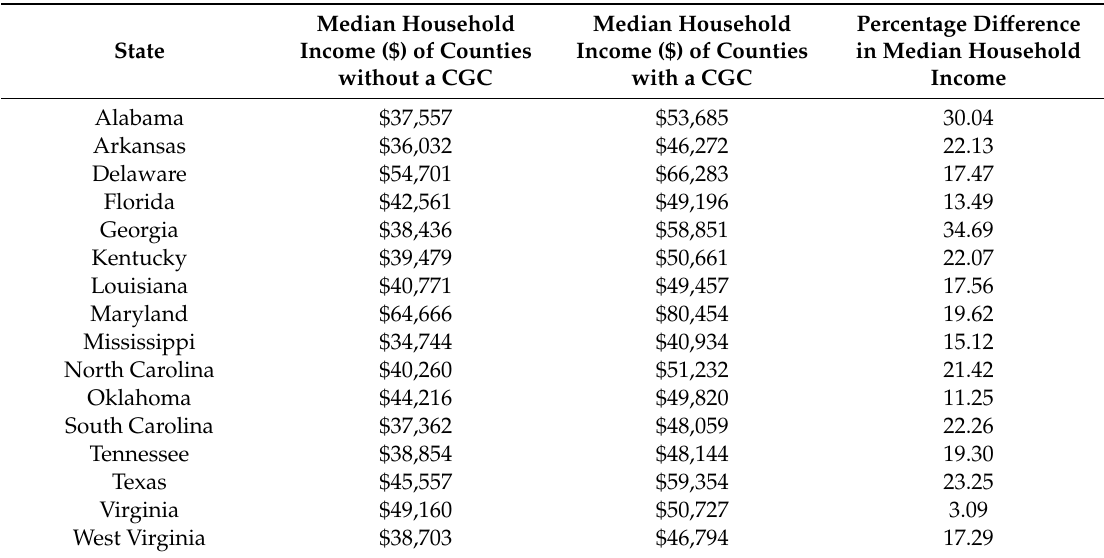
Table 2. Median household income of the counties with certified genetic counselors (CGC) in each state of the Southern United